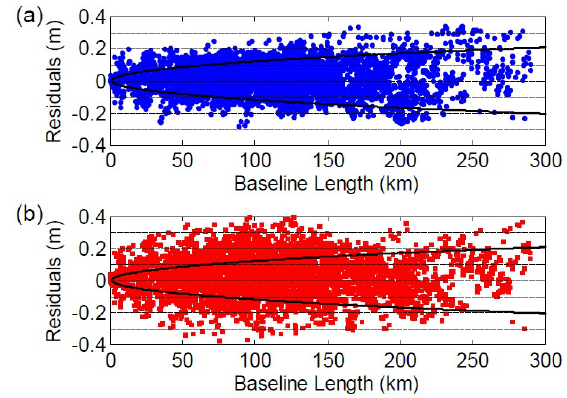
Figure 4: Snowy Mountains residuals between (a) AUSGeoid09- and (b) AUSGeoid98-derived and oflcial AHD height differences over 5,356 possible vectors. The unbroken line describes the allowable 3 rd order differential levelling misclose.